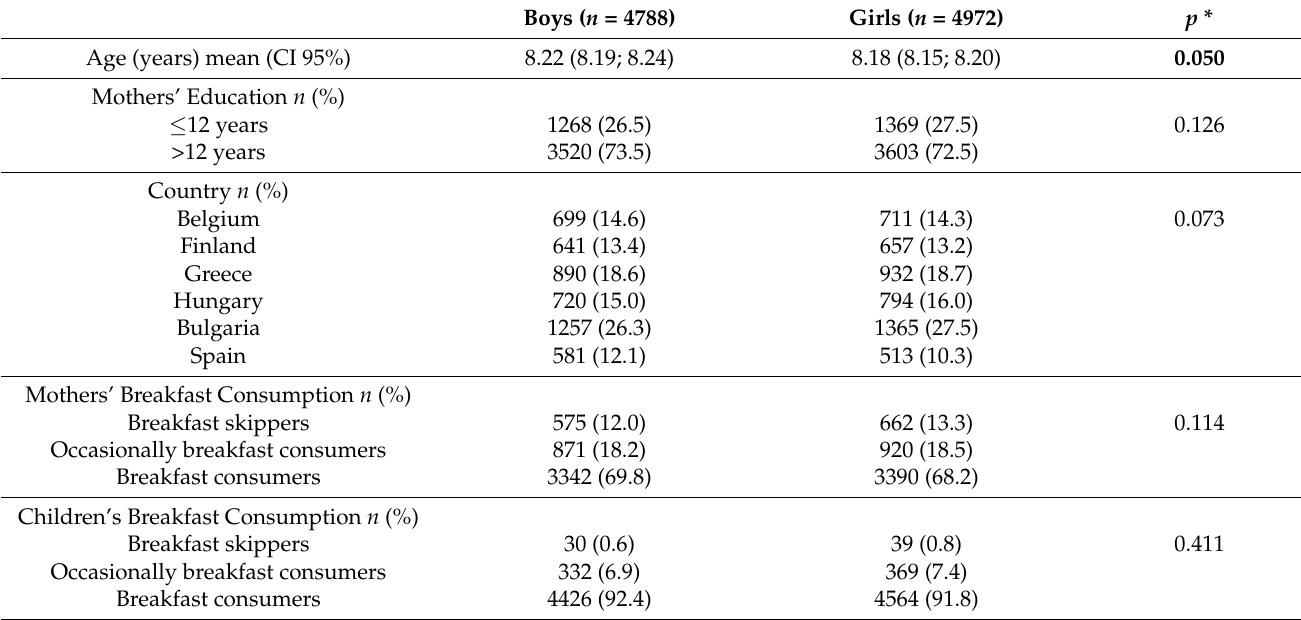
Table 1. Descriptive characteristics of the sample of European children from the Feel4Diabetes study ( n =